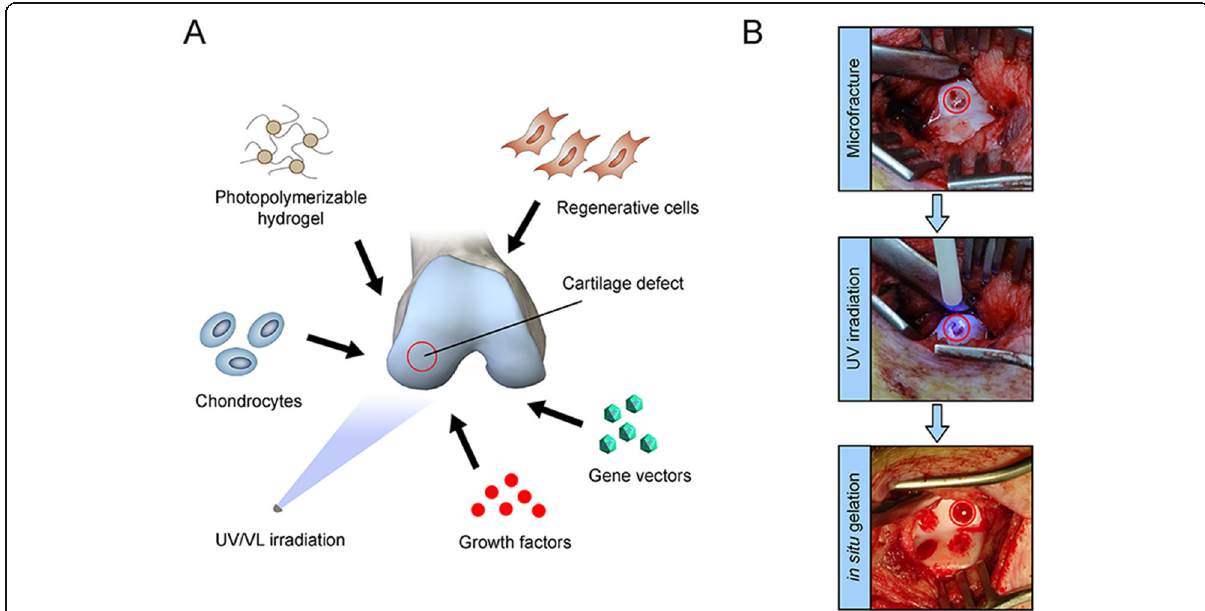
Fig. 1 Application of photopolymerizable hydrogel systems for translational cartilage repair. ( a ) Principle of providing a photopolymerizable hydrogel carrying cells (regenerative cells, chondrocytes) and/or specific growth factors or gene vectors as controlled delivery platforms to sites of articular cartilage damage (hydrogel gelation can be performed ex vivo or in situ following radiation with ultraviolet - UV - or visible light - VL). ( b ) Intra-operative administration of a photopolymerizable hydrogel accompanied with microfracture into a focal full-thickness chondral defect allowing for in situ gelation via UV light